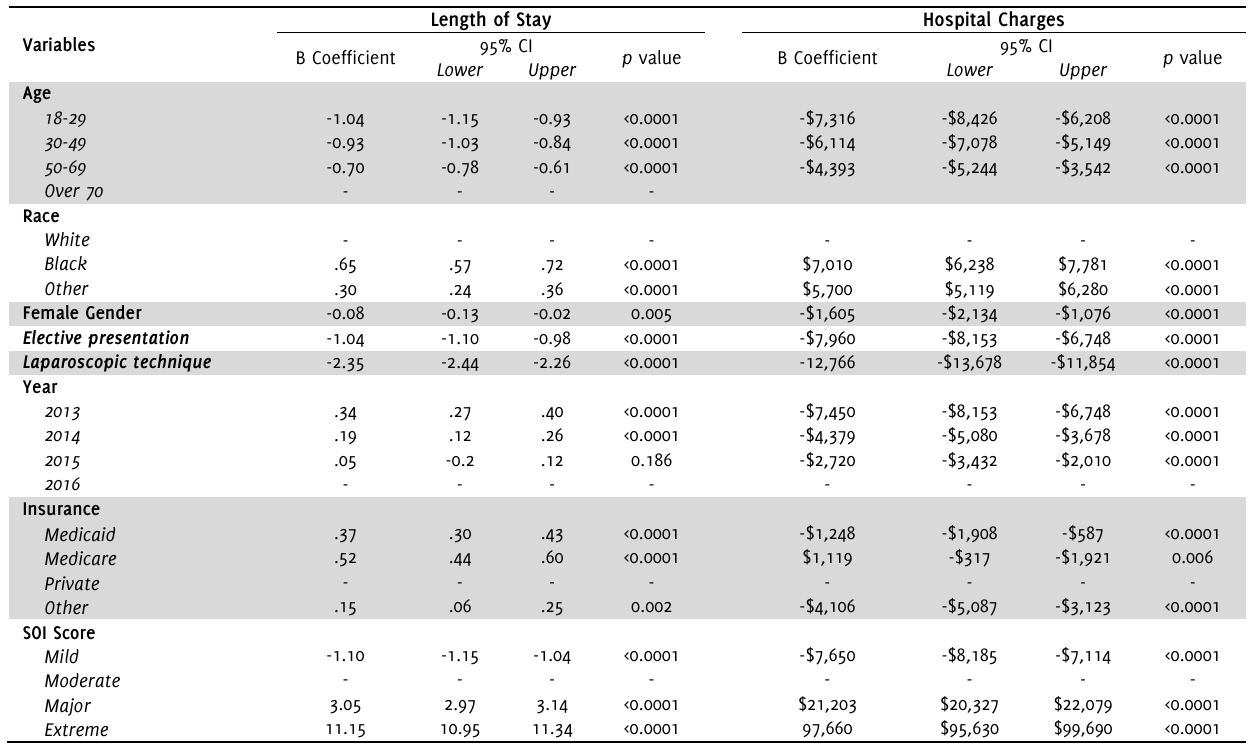
Table 5. Multivariable Predictor for Length of Stay and Hospital Charges